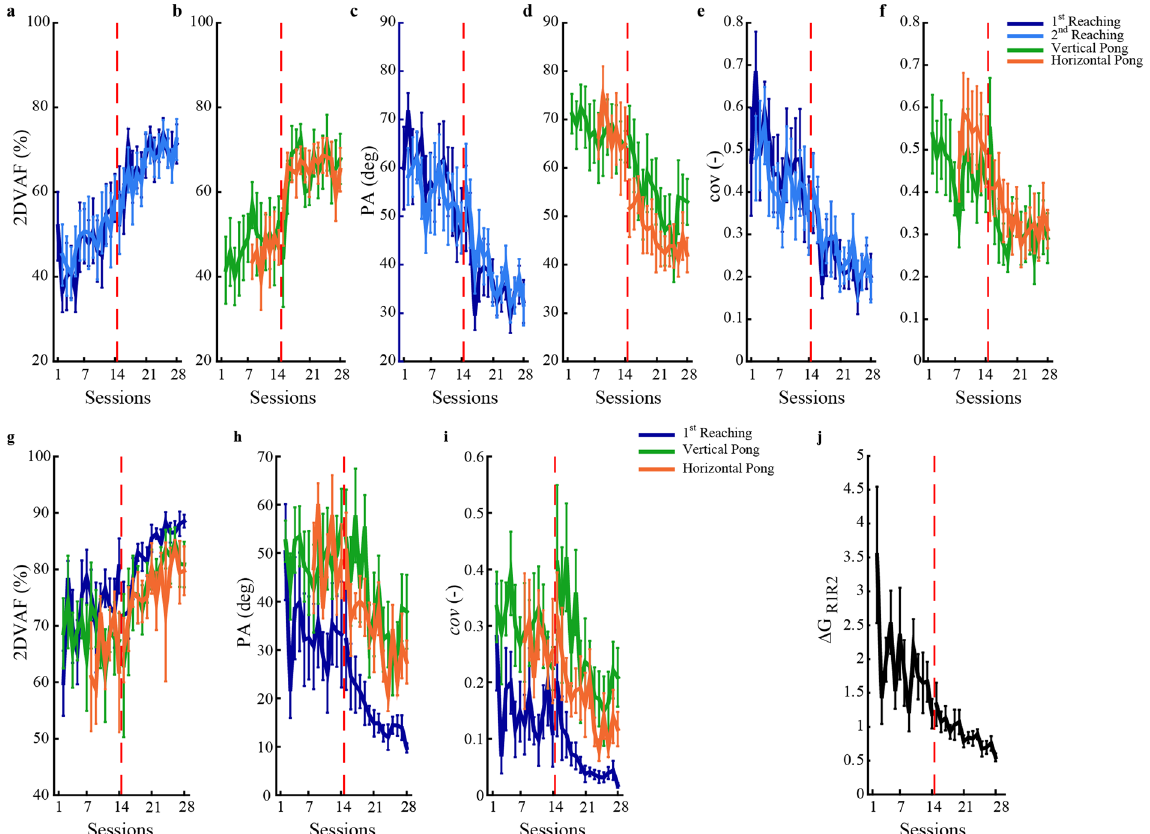
Figure 6. Tasks comparison. Variance accounted for ( a and b ), principal angle ( c and d ) and covariance index ( e and f ) for the tasks of reaching ( a , c , e ) and vertical and horizontal pong ( b , d , f ) based on the two main calibration eigenvectors. Mean value across the participants and the standard error are presented. ( g – i ) Variance accounted for, principal angle and covariance index extracted from the comparison of the 1 st reaching block (blue line), vertical pong (green line) and horizontal pong (orange line) with the 2 nd reaching block. ( j ) stability of the inverse body-to-cursor transformation across sessions, estimated with the target coordinate. For all the metrics mean value and standard errors are